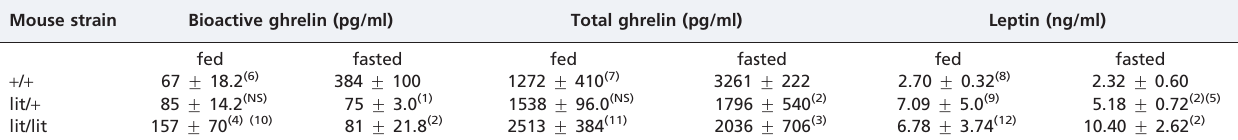
Table 1 - The plasma ghrelin and serum leptin concentrations in fed and 16-hour-fasted little (lit/lit), heterozygous (lit/ + ), and wild-type ( + / + )